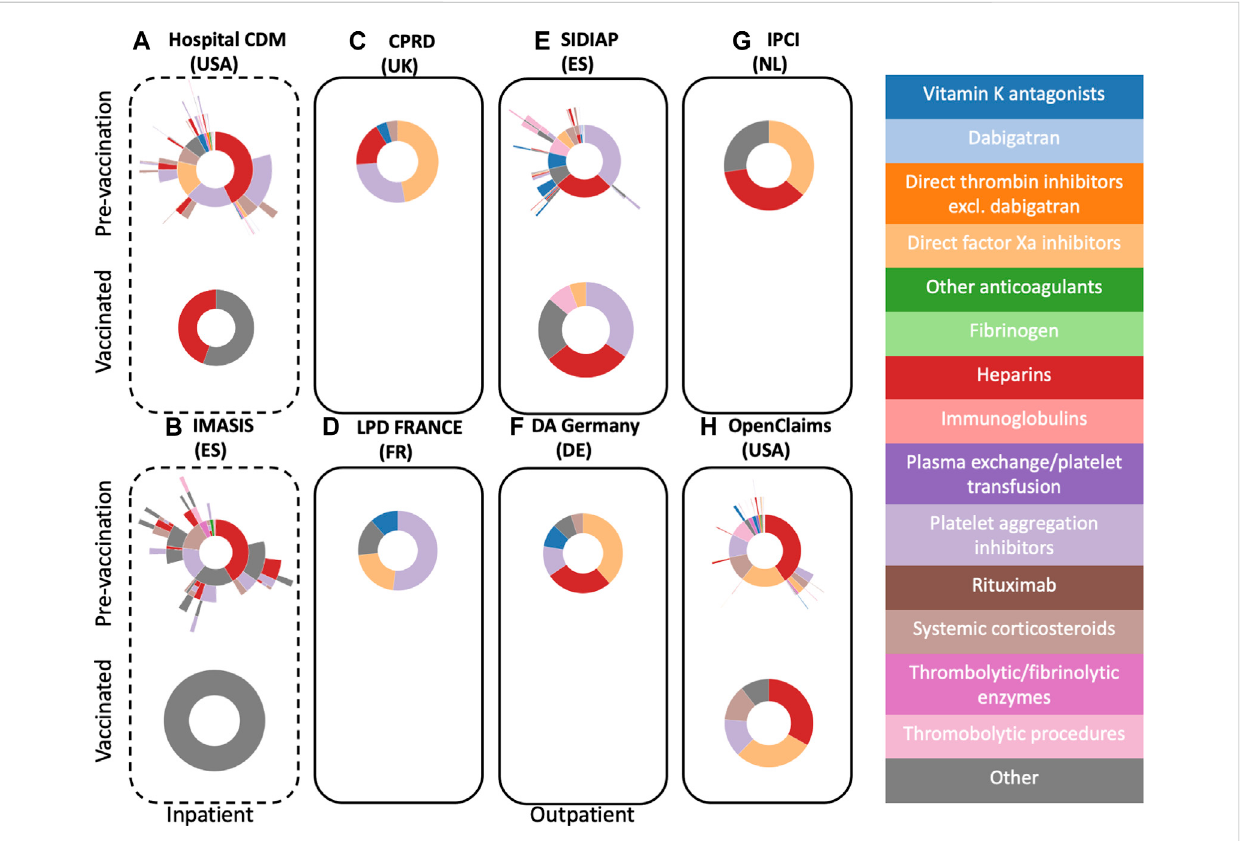
FIGURE 1 Sunburst plots visualizing treatment pathways for TTS patients in pre-vaccination cohorts (top) versus vaccinated cohorts (bottom). Inpatient databases are depicted with a dashed line frame, whilst outpatient ones have a solid